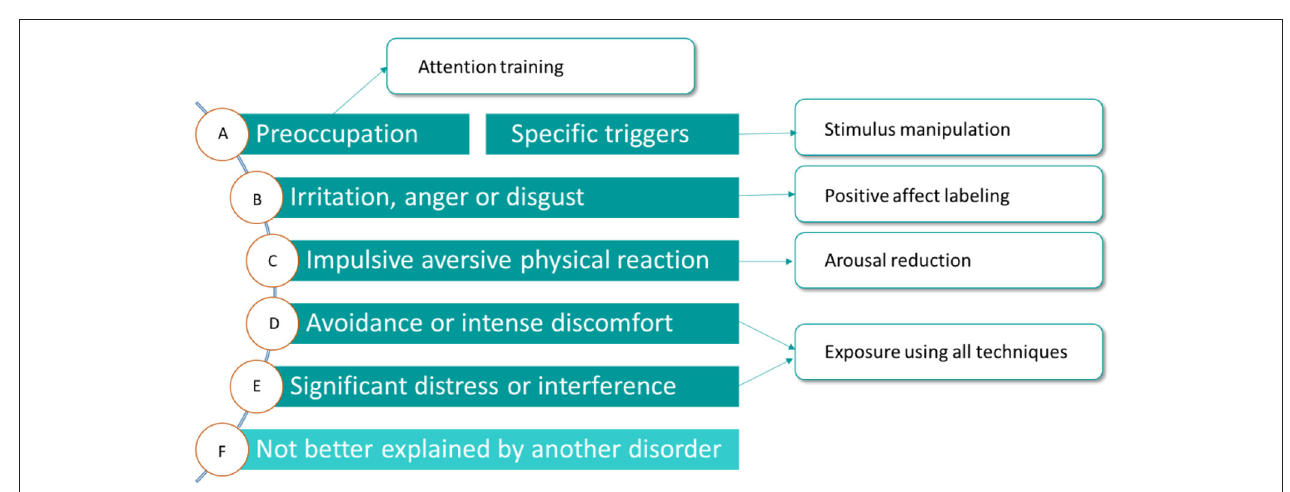
FIGURE 2 | Amsterdam UMC revised criteria for misophonia and corresponding